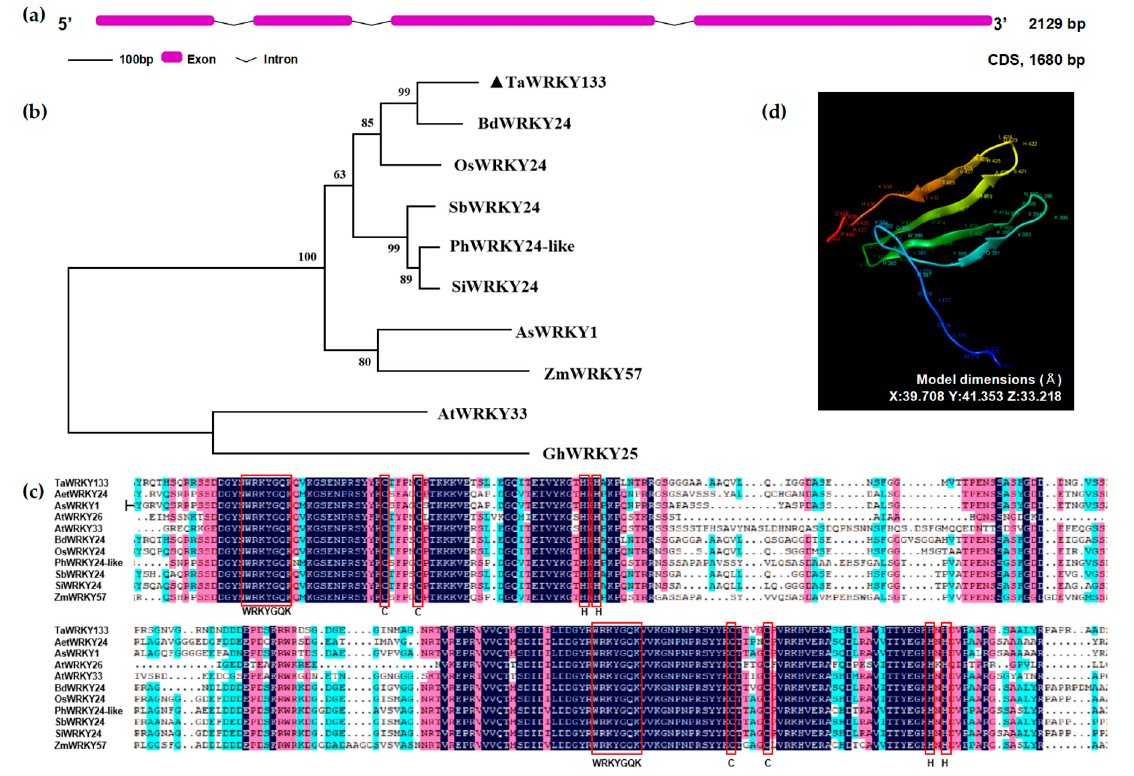
Figure 1. Bioinformatics alignment of TaWRKY133. ( a ) Gene structure model of TaWRKY133 . ( b ) Phylogenetic tree of TaWRKY133 and homologous genes in other species. ( c ) Alignment of amino acid sequences of TaWRKY133 with homologous gene sequences in other species. ( d ) Tertiary structure prediction model of the TaWRKY133 protein.